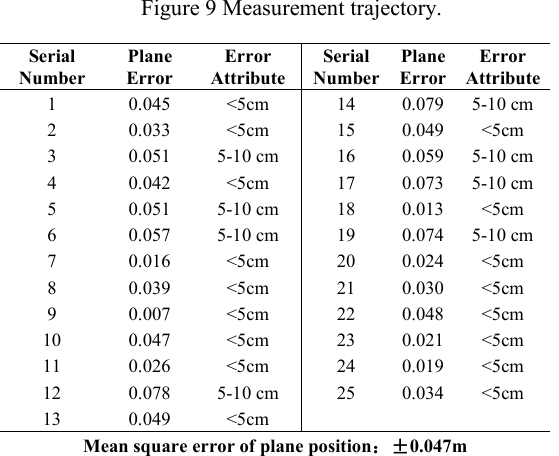
Table 1 The comparison of accuracy of point cloud coordinates and detection point